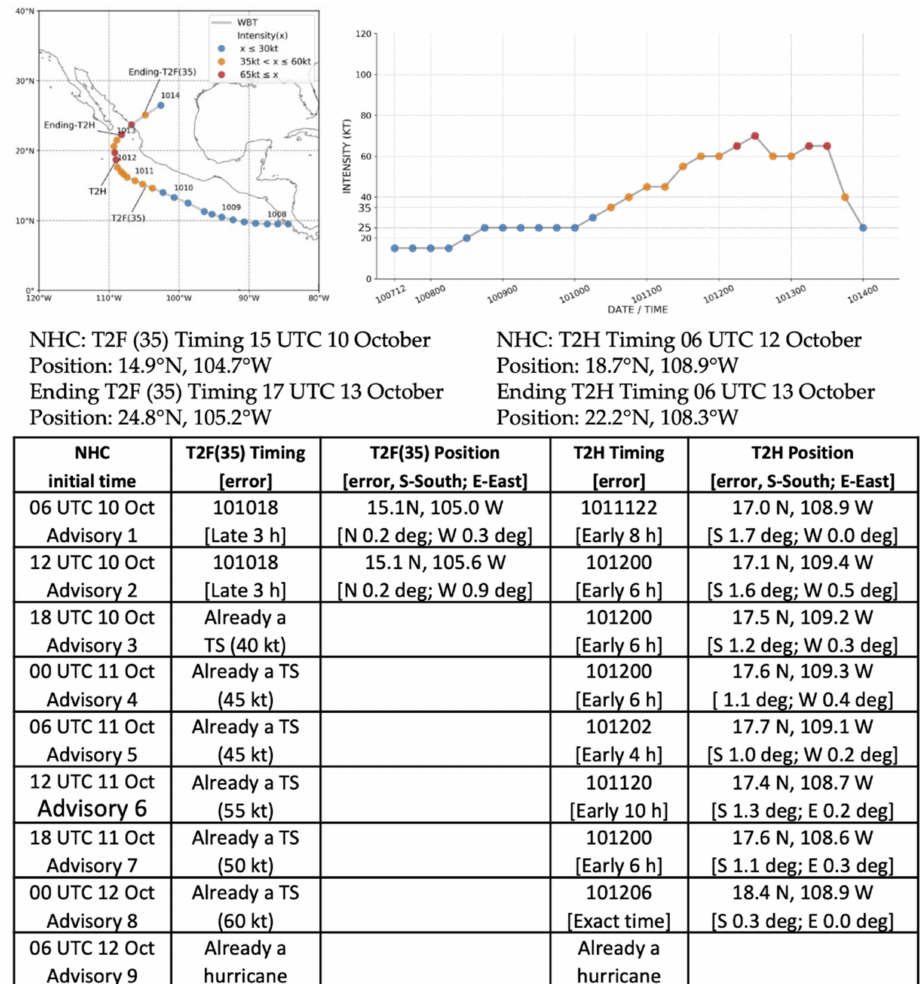
Figure 14. National Hurricane Center (NHC) forecasts of the T2F(35) and the T2H timing and positions based on NHC Advisories as in Figure 4, except during